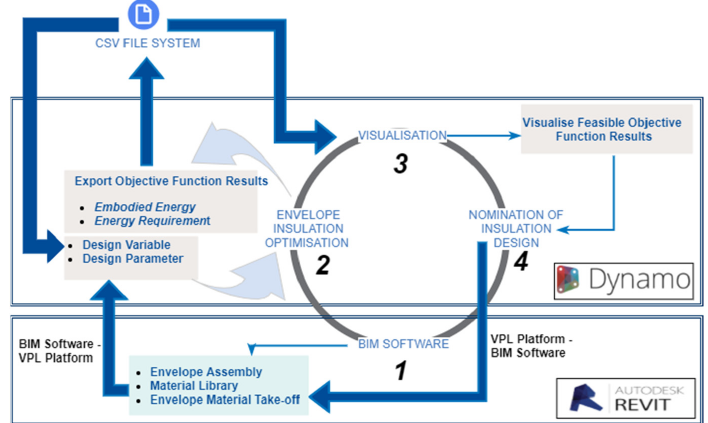
Figure 1. An overview of building information modelling (BIM)-based Envelope Insulation System Optimisation Framework.